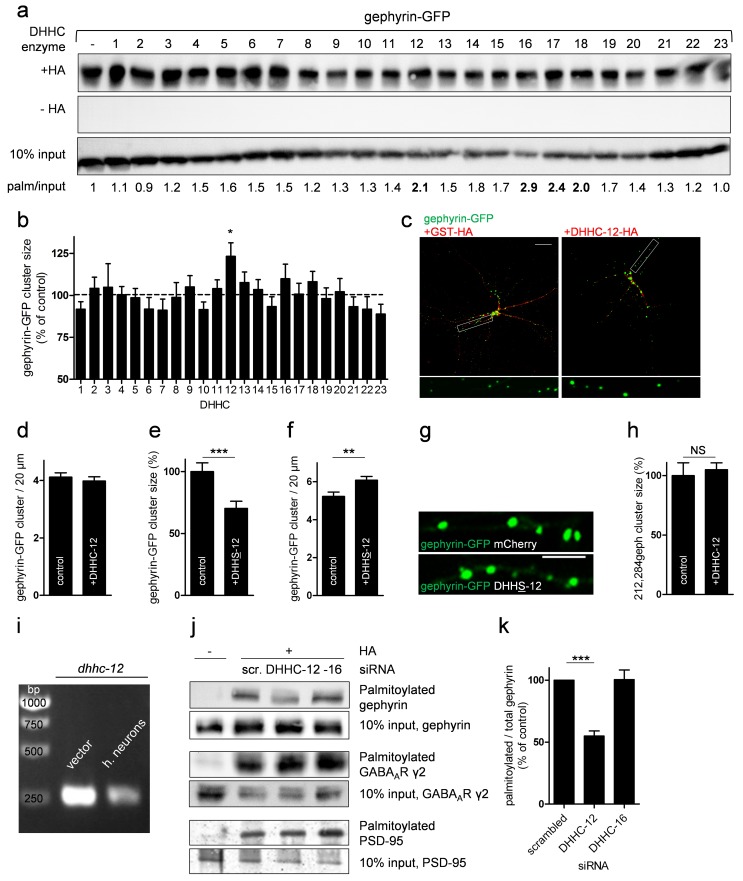
Gephyrin is palmitoylated by DHHC-12.(a) Individual HA-tagged DHHC proteins or GST-HA as control were co-expressed with gephyrin-GFP for 24 h in HEK293 cells and analyzed with the ABE assay. Omitting hydroxylamine demonstrated specify of the assay. (b) Gephyrin-GFP was co-expressed with individual HA-tagged DHHC enzymes or GST-HA as control in primary hippocampal neurons, and gephyrin cluster size was quantified by confocal laser scanning microscopy. In the histogram, DHHC enzymes are labeled according to [16]. (c) Representative images show phenotypical differences of gephyrin-GFP clusters in DHHC-12–expressing neurons compared to GST-expressing controls. Scale bar, 10 µm. (d) Gephyrin-GFP cluster density after 24 h expression of DHHC-12 compared to control neurons. (e–g) Quantification of gephyrin-GFP cluster size and density and representative image upon expression of dominant-negative DHHS-12–HA compared to mCherry-expressing control neurons. Scale bar, 5 µm. (h) Quantitative analysis of 212,284Geph cluster size in control mCherry and DHHC-12-HA–expressing neurons. (i) Expression of dhhc12 mRNA in cultured hippocampal neurons (h. neurons) was validated by PCR using cDNA prepared from neurons. A plasmid encoding the respective dhhc gene was used as control. (j) Primary hippocampal neurons were grown in medium containing cell-penetrating siRNAs to knock down expression of DHHC-12 or DHHC-16. Lysates were subjected to ABE, and the palmitoylation level of gephyrin, GABAAR γ2, and PSD-95 was analyzed by immunoblotting. We used 10% of the lysate to detect total levels of the respective proteins; scr., scrambled. (k) Quantification of three independent experiments shows gephyrin palmitoylation levels normalized to total protein (***p<0.001 using Student's t test).